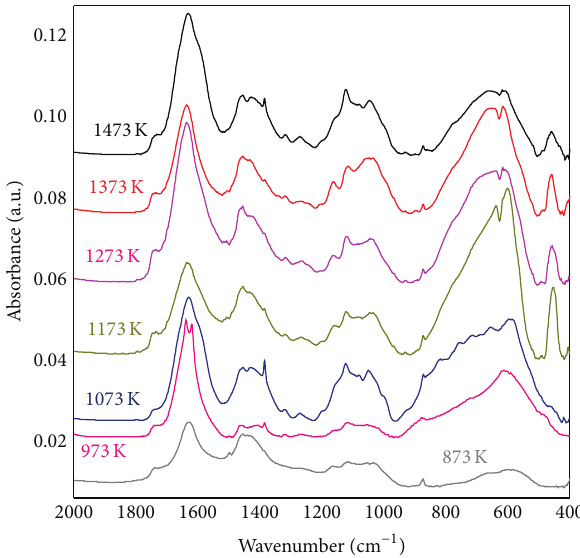
Figure 5: FTIR spectra of oxidized PM2000 at various temperatures from 873 K to 1473